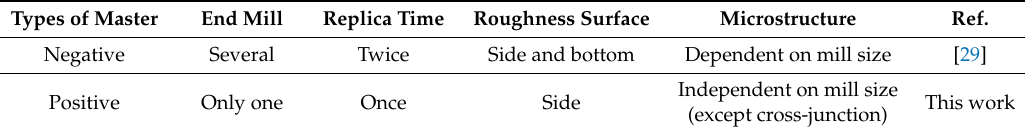
Table 3. Comparison of the features between positive master and negative master for PDMS molding. Types of Master